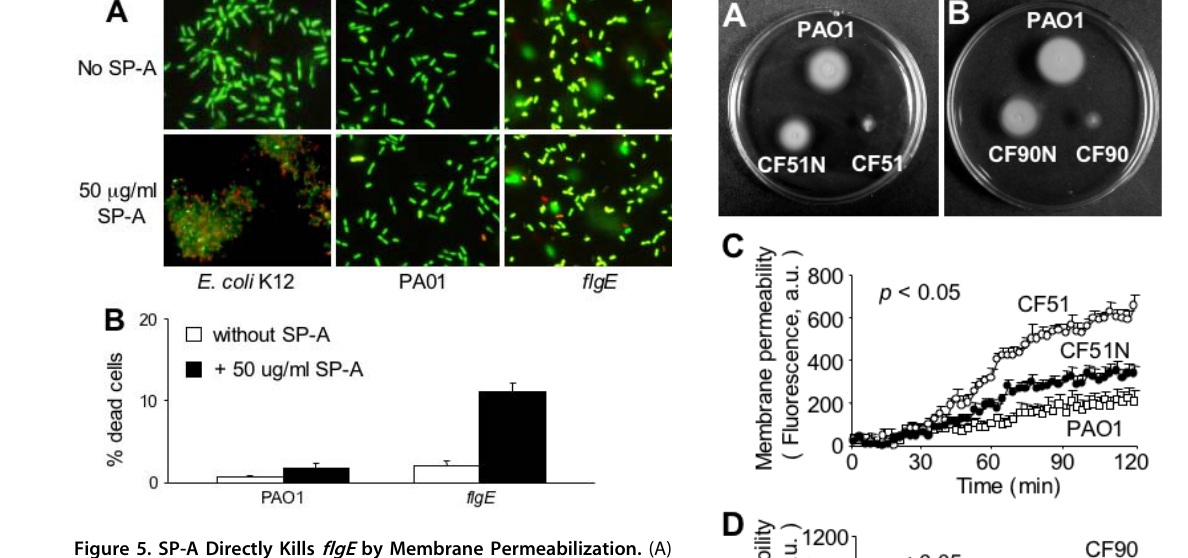
Figure 6. Nonmucoid Motile Revertants of Clinical CF P.aeruginosa Strains Are More Resistant to SP-A-Mediated Membrane Permeabi- lization Than Their Parental Isolates. (A–B) The mucoid clinical CF P. aeruginosa strains CF51 and CF90 were nonmotile, whereas their nonmucoid motile revertants CF51N and CF90N had regained their flagellar-based motility on swimming motility agar plates. The wild-type strain PA01was used as control for motility assay. (C–D) Both CF51N and CF90N were more resistant to SP-A-mediated membrane permeabiliza- tion than their parental isolates, CF51 and CF90, respectively. Data are the mean 6 SE, n =8 for each bacterial strain. The differences in membrane permeabilization between CF51 versus PA01; CF51 versus CF51N; and CF51N versus PA01 were significant from 43 rd -min, 53 rd -min and 53 rd -min onward, respectively. * p , 0.05. The difference in membrane permeabilization between CF90 versus PA01; CF90 versus CF90N; and CF90N versus PA01 was significant from 38 th -min, 28 th -min, and 43 rd -min onward, respectively. * p ,